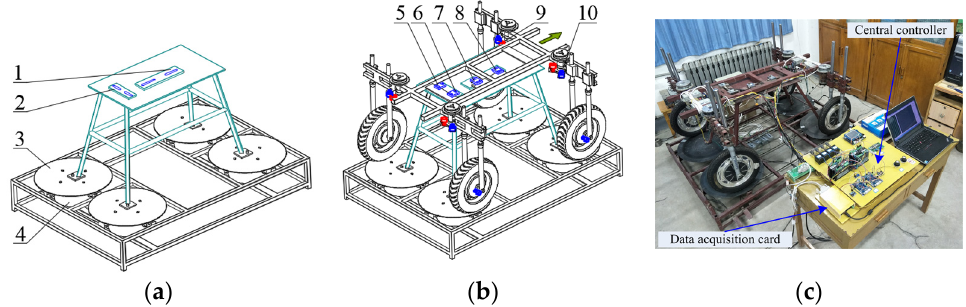
Figure 5. Diagram of experimentation: ( a ) Structure diagram of test bench; ( b ) Diagram of bench test; ( c ) Photo of test bench. 1. Longitudinal limiting groove; 2. Lateral limiting groove; 3. Horizontal turntable; 4. Turntable driving motor; 5–8. Force sensor installation position; 9–10. Angle sensor installation position.